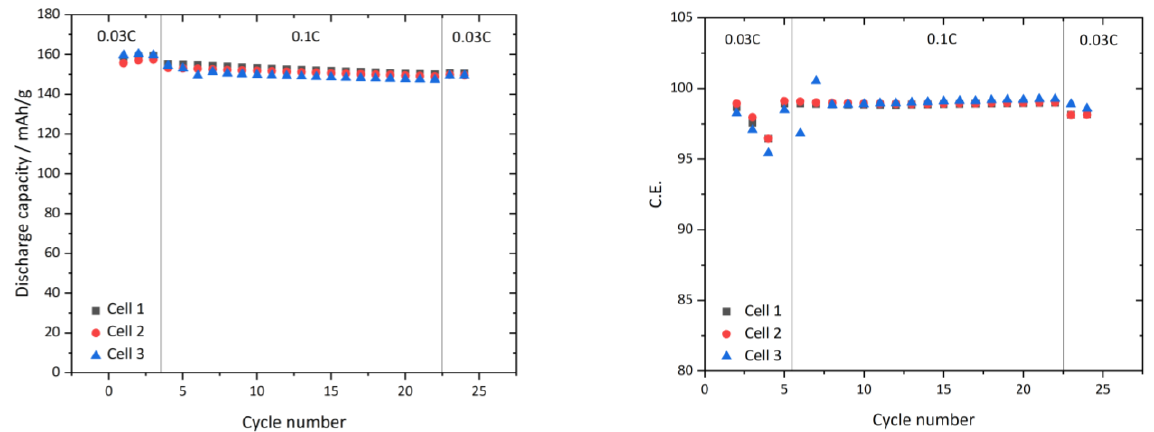
Figure 8. ( Left ): 0.03C and 0.1C capacity of 3 full cells with infiltrated and laminated NMC and LTO, respectively with PCPIS at at 45 °C; ( Right ): coulomb efficiency of tested cells shown on the left.